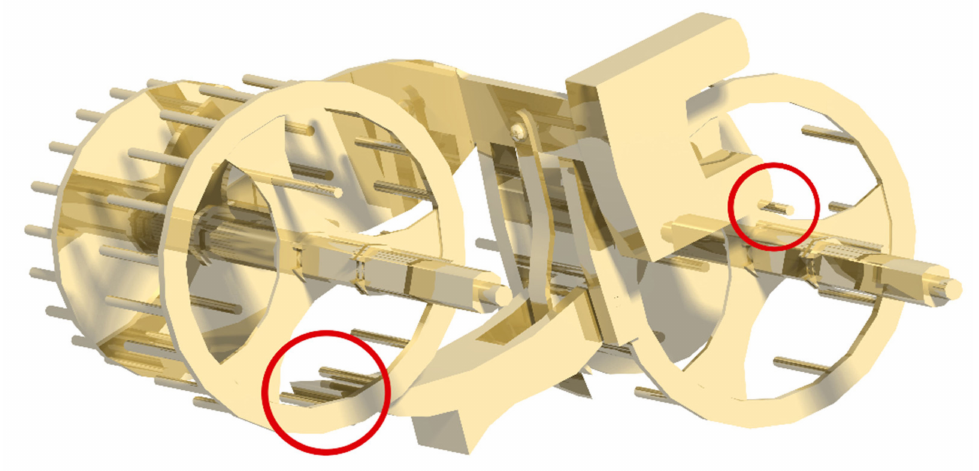
Figure 12. Points of contact of the carry mechanism with the two